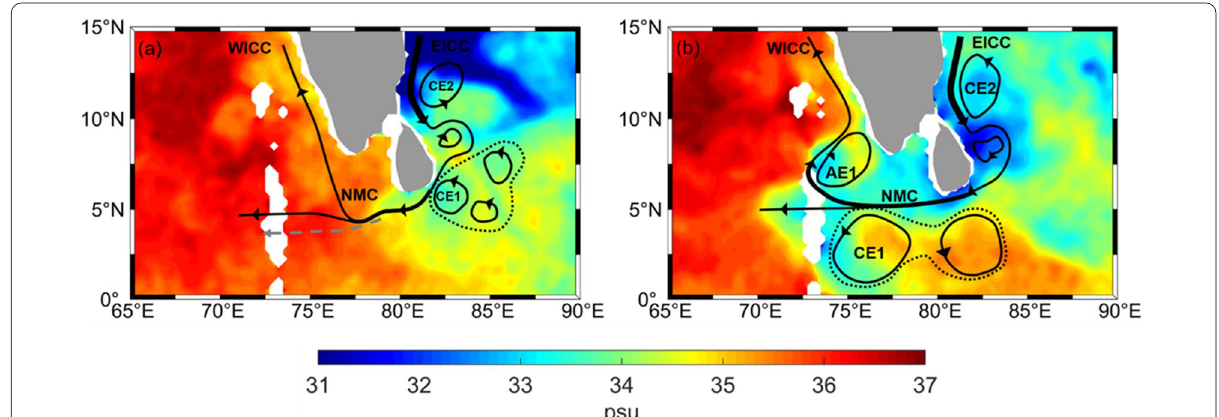
Fig. 8 Schematic diagram of EICC, WICC, NMC, and eddies along India. a 2016.11.02; b 2016.12.12. The thickness of the bold curve represents the velocity of the current, and the thicker the curve, the greater the velocity. AE Anticyclonic Eddy, CE Cyclonic Eddy. The dashed contours label the regions with negative